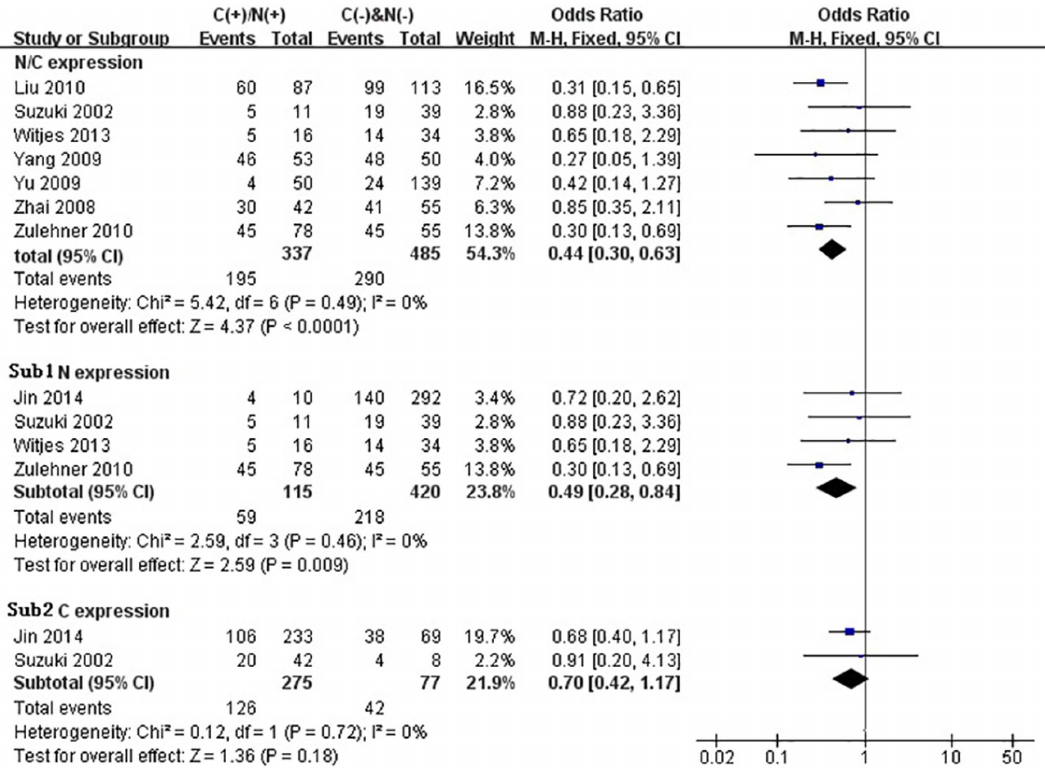
Figure 5. Forest plot of odds ratio for the association of b -catenin expression in cytoplasm and/or nucleus with vascular invasion by subgroup analysis. Sub1: in cytoplasm alone. Sub2: b -catenin expression in nucleus alone.